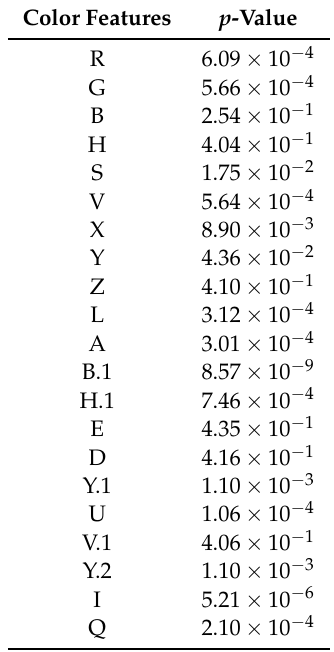
Table 1. Color features chi - square test